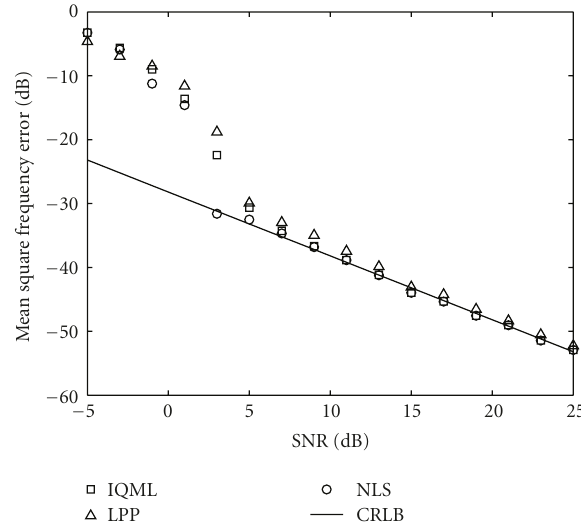
Figure 11: MSE for ω of single real sinusoid with random φ